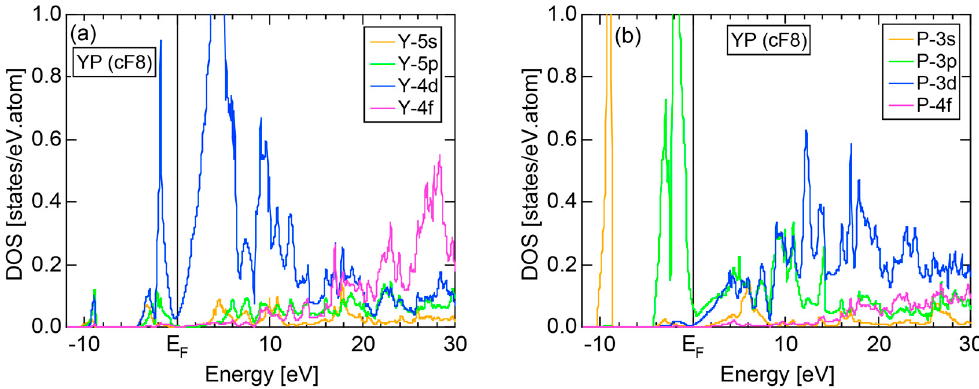
Figure 72. ( a ) Y- and ( b ) P-pDOSs for YP (cF8).